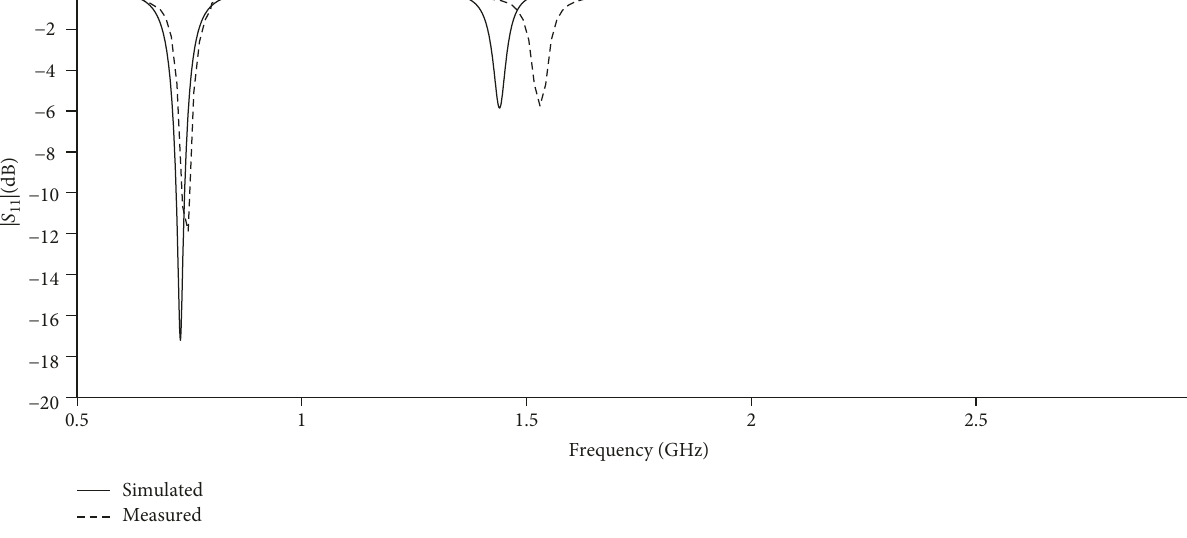
Figure 6: Re fl ection coe ffi cient simulation and experimental results of the SSO optimized Koch fractal antenna.